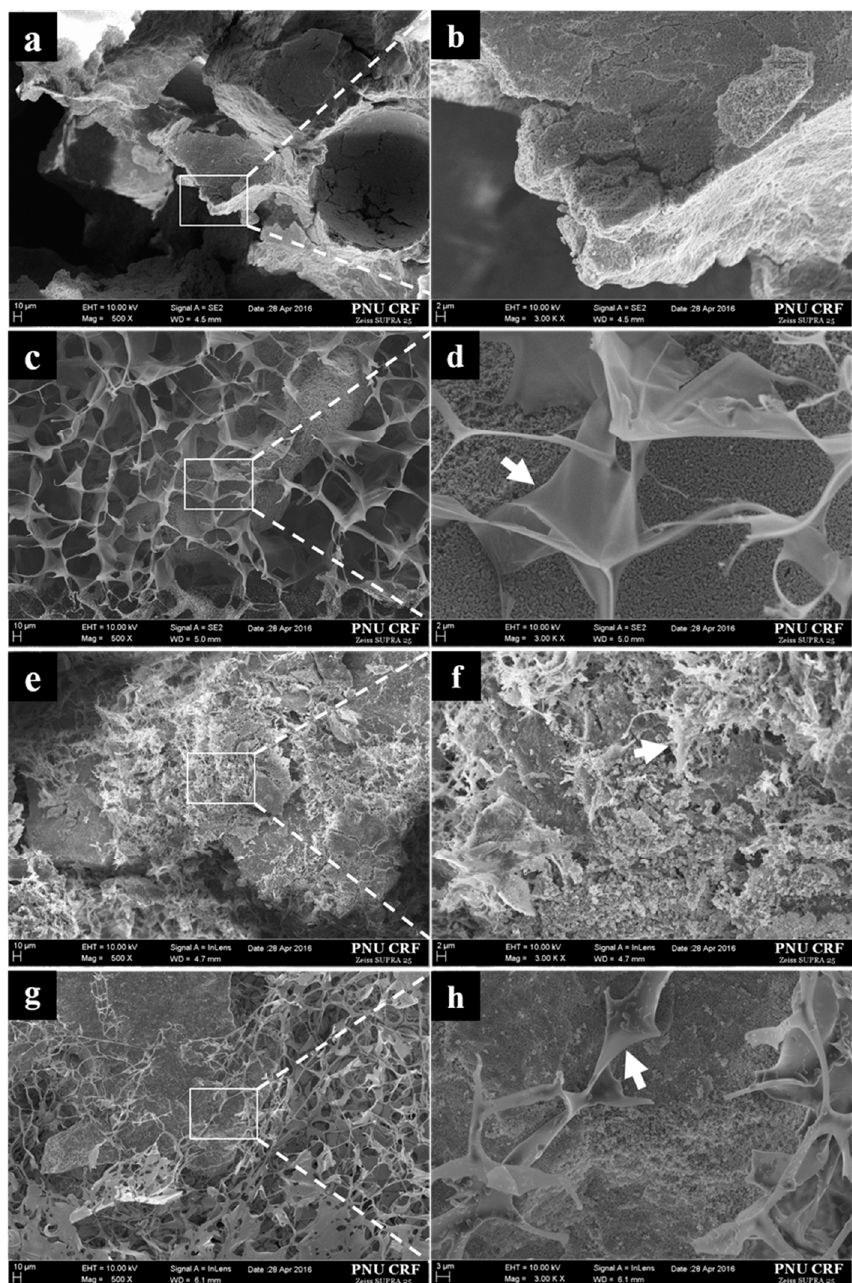
Figure 5. SEM images of bone graft materials. Surfaces of: ( a , b ) BCP; ( c , d ) BCP/CMC; ( e , f ) BCP/c-CMC; and ( g , h ) BCP/HyA samples. White arrow indicates polysaccharides (original magnifications: ×500 ( a , c , e , g ); and ×3000 ( b , d , f , h )).